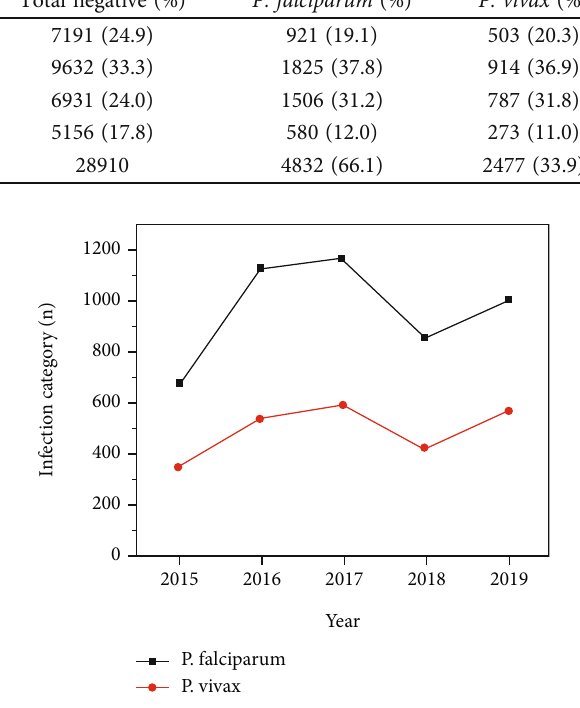
Table 3: Seasonal pro fi le and prevalence of malaria at MHC during 2015-2019. Summer (Jun. to Aug.)